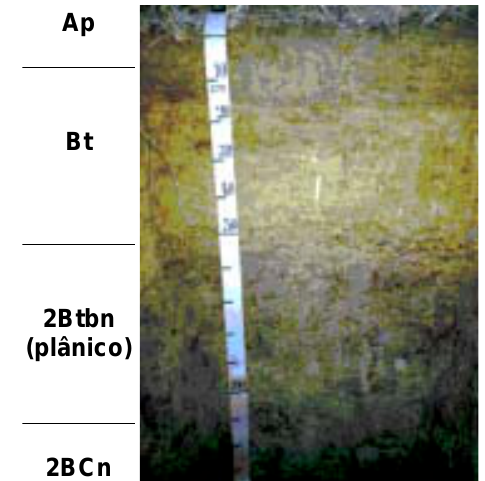
Figura 2. Perfil 2 - Argissolo Amarelo eutrófico planossólico solódico, mostrando a nítida separação entre o horizonte Bt e o